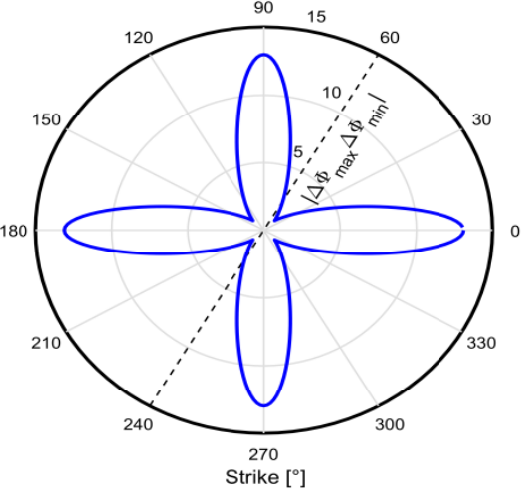
Figure 16. Sensitivity analysis of the strike angle of the injection fracture model to the residual phase tensor.